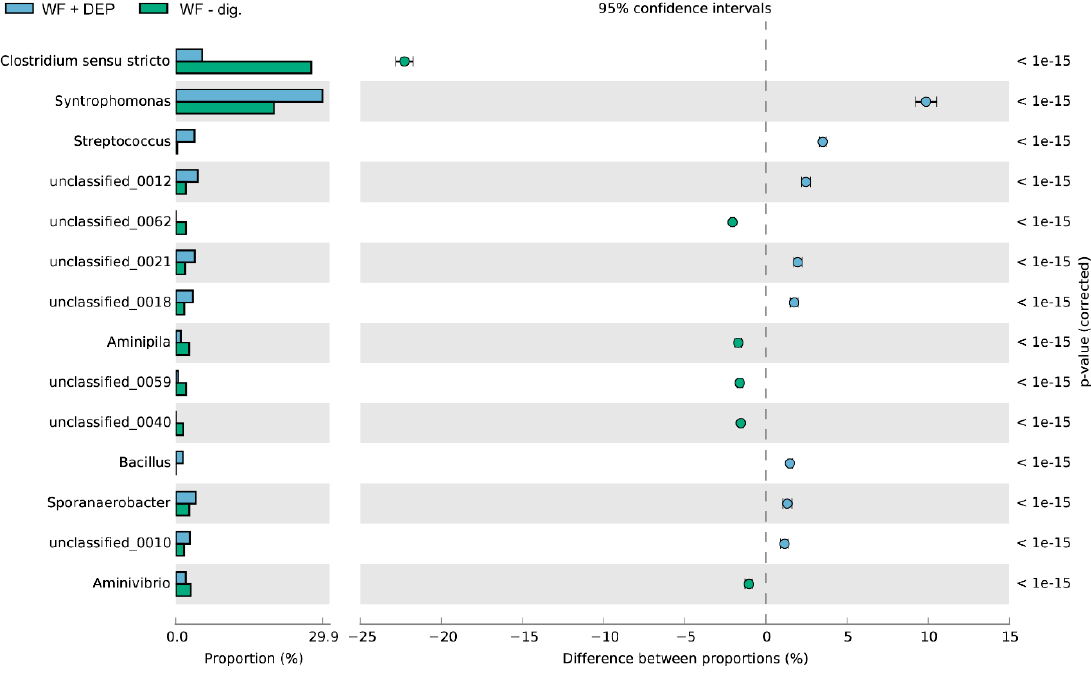
Figure 8. Comparison of bacteria genus composition between WF + DEP and WF-dig. variants.